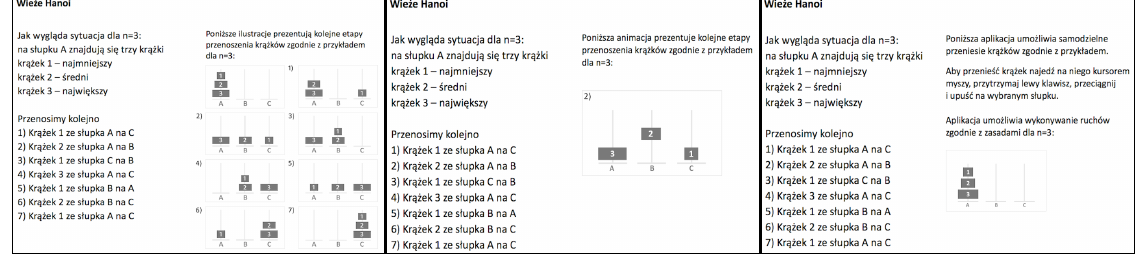
Figure 1. Example of Towers of Hanoi visualizations on screen